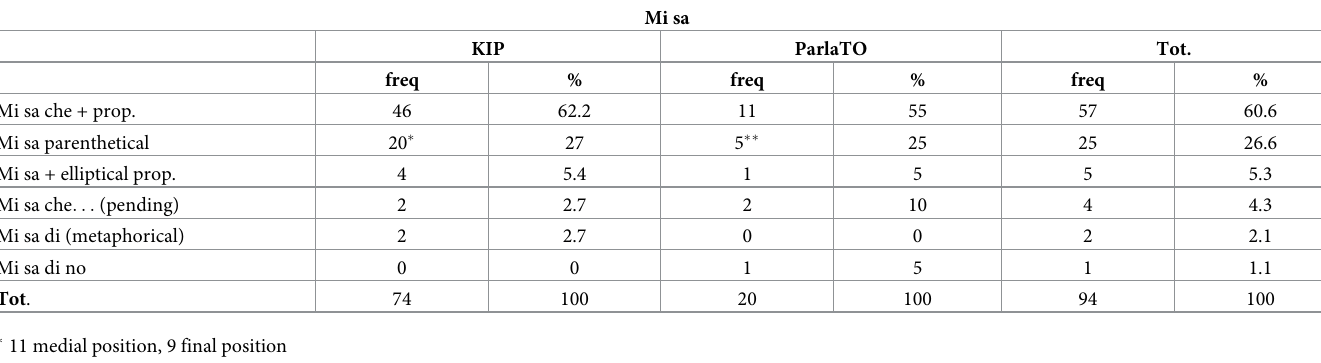
Mi sa che [(lit. to me it knows that) I think/guess . . . that] followed by a proposition; Mi sa parenthetical, both in medial and final position; Table 1. Occurrences of mi sa in KIP and